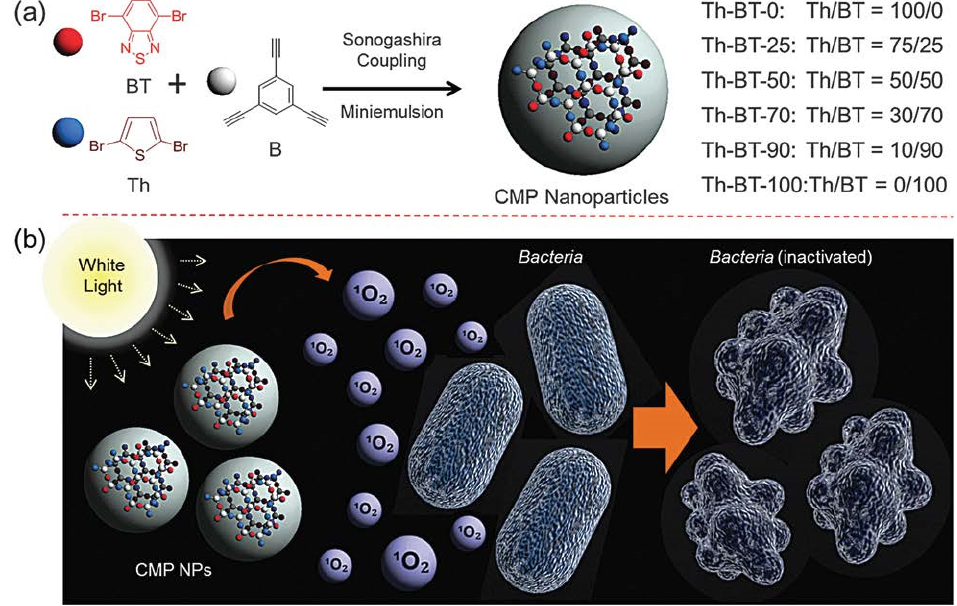
Figure 2. ( a ) Illustration of conjugated microporous polymer nanoparticles, route of synthesis, and proportion of monomers in the polymer skeleton. ( b ) Schematic diagram of bacterial inactivation mechanism of conjugated microporous polymer nanoparticles. Reproduced from Ref. [29] with permission from the Royal Society of